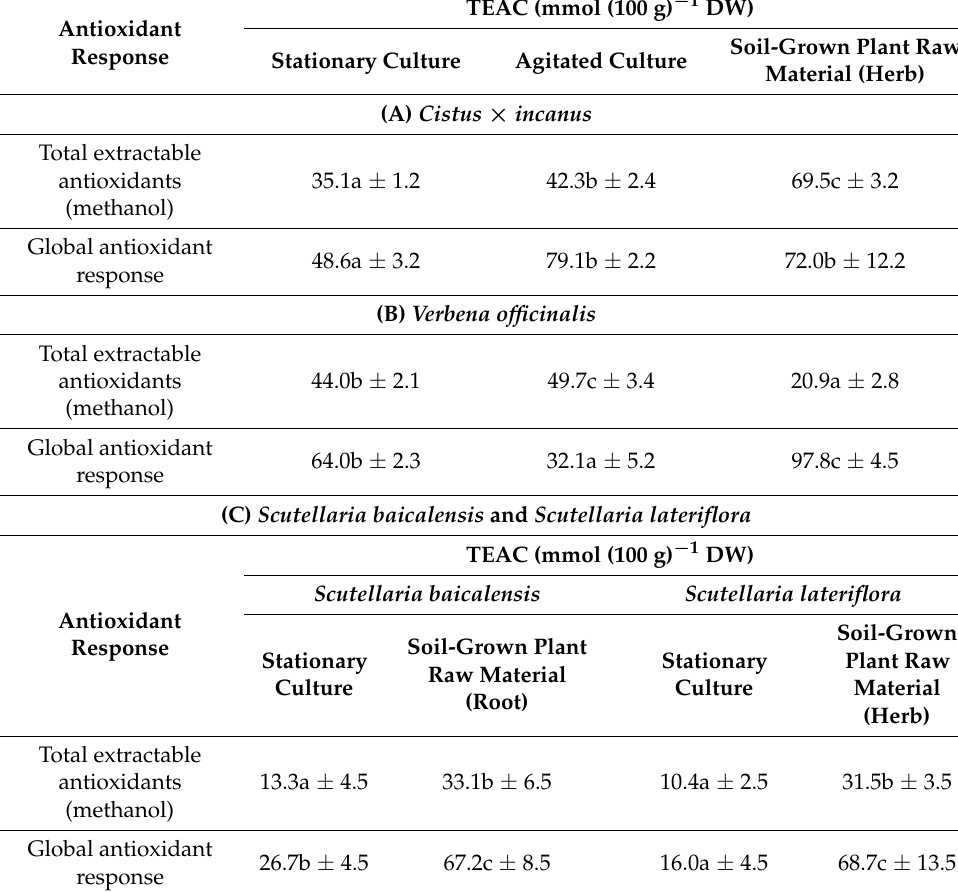
Table 1. Trolox equivalent antioxidant capacity (TEAC (mmol (100 g) − 1 dry weight (DW)) in extracts of biomasses from in vitro and soil-grown plant raw materials of Cistus × incanus (A) , Verbena officinalis (B) , and Scutellaria baicalensis and Scutellaria lateriflora (C) . Mean values ± SE, the same superscript letter means lack of statistical significance between treatments (n = 5, p <